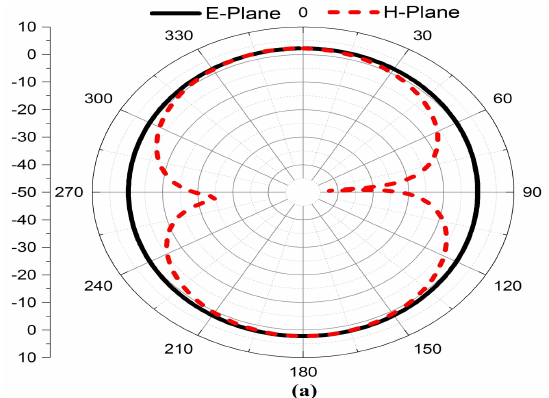
Figure 12: Simulated radiation pattern in E-plane and H- plane at: (a) 3.5 GHz, (b) 5.2 GHz (c) 5.8 GHz, (d) 10